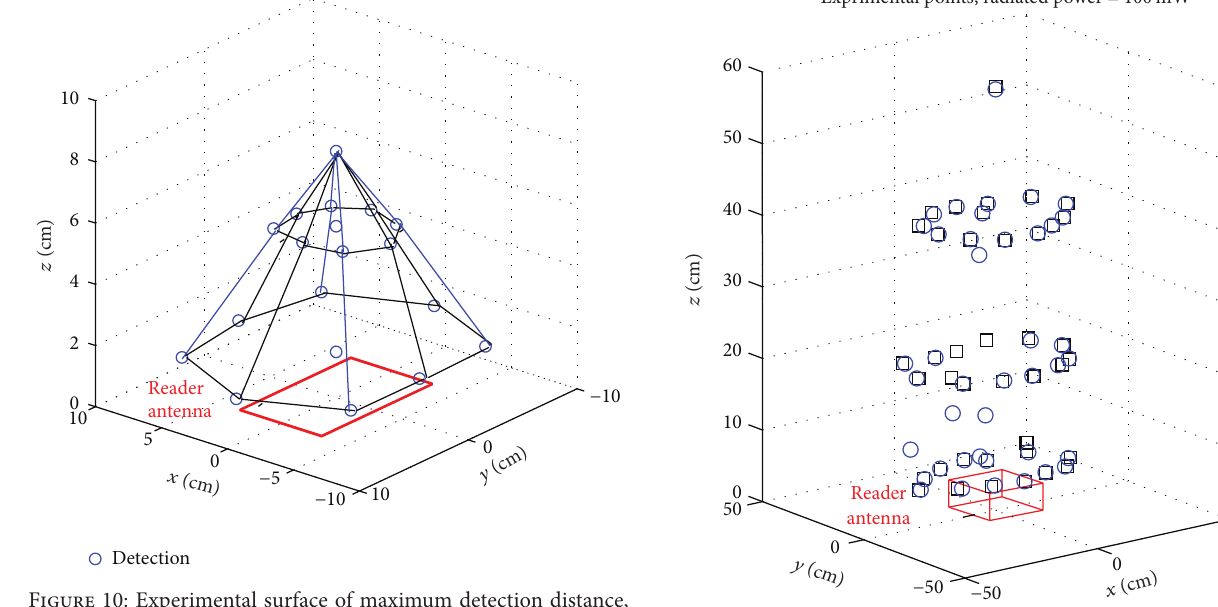
F 10: Experimental surface of maximum detection distance, HF RFID system.